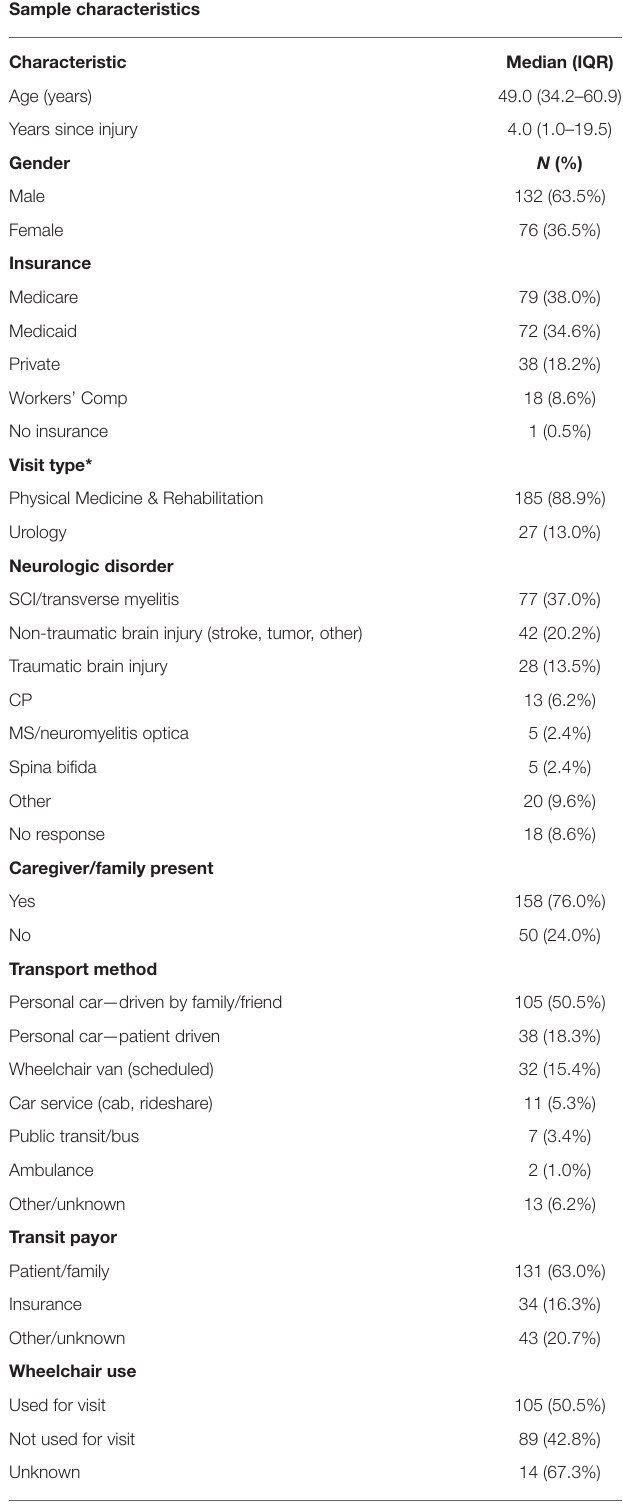
TABLE 1 | Population demographics, injury characteristics, and transportation. Sample